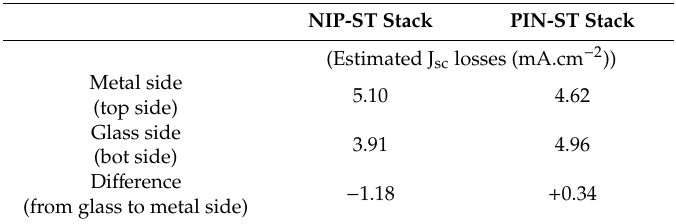
Figure 6. ( a ) Transmittance and ( b ) reflectance curves of the layers that surround the perovskite layer depending on the PSC’s architecture (NIP or PIN) and the illumination side (glass side or metal/ITO side), and ( c ) the corresponding areas integrated beneath these transmittance curves within the perovskite absorption range (300–765 nm). Table2. Calculatedcurrent(J sc )lossesestimatedfromtransmittancemeasurements(Figure6)depending on the side of illumination in both NIP- and PIN-type